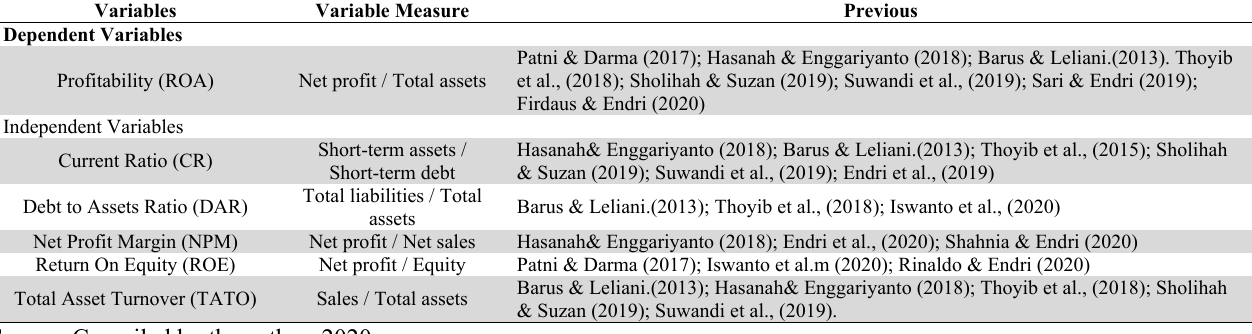
Variable used in the research